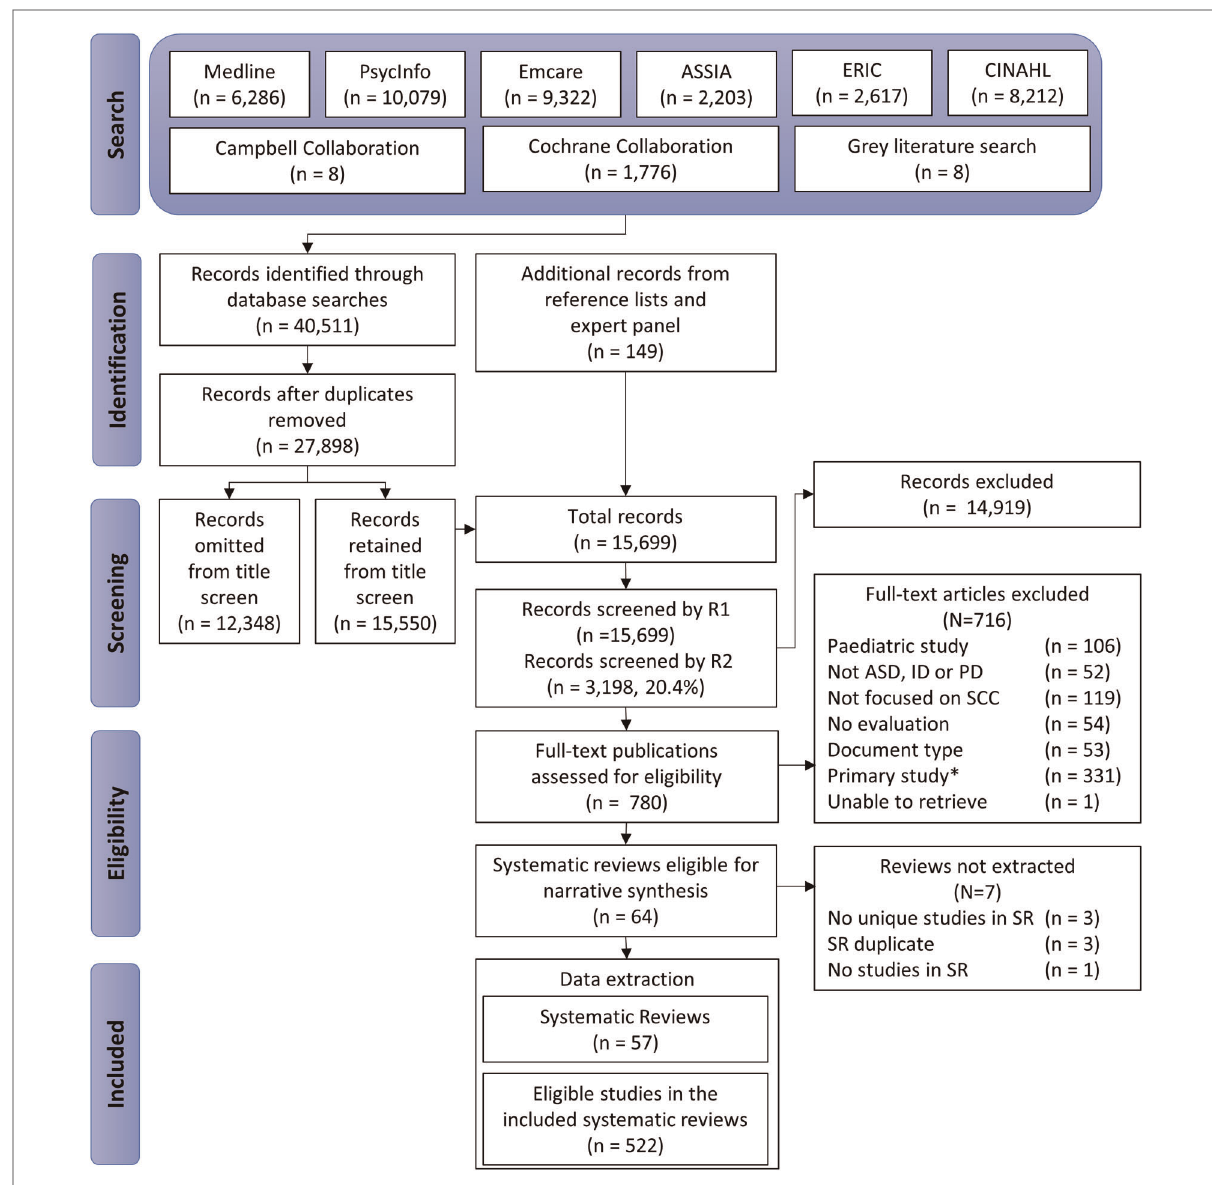
FIGURE 1 PRISMA chart. * These studies met the SPIDER study design eligibility criteria but did not meet the criteria for inclusion in an umbrella